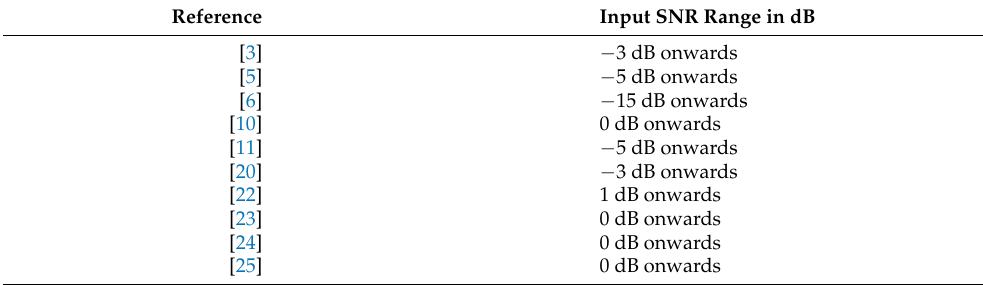
Table 1. Publications with performance evaluations on input